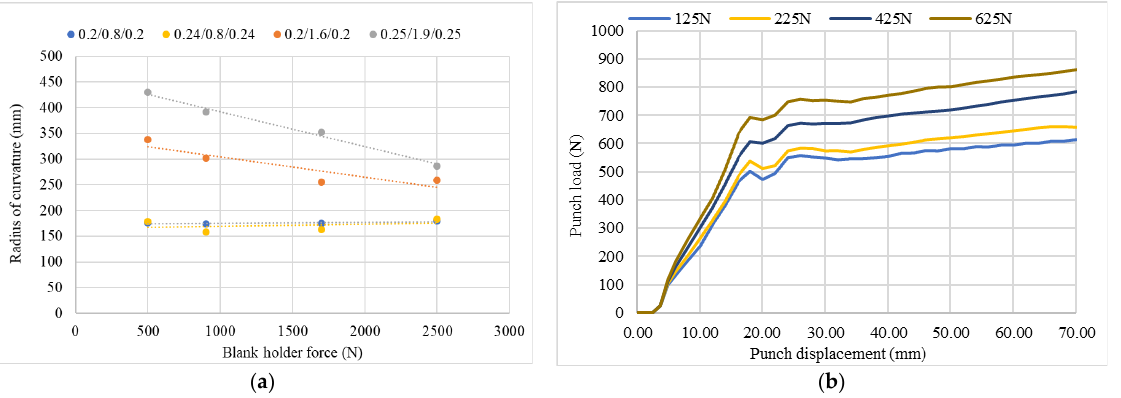
Figure 18. ( a ) Effect of BHF on radius of curvature ( b ) Load – displacement curves for varying blank holder force for the sandwich laminate with 0.24/0.8/0.24 mm thickness combination (the BHFs shown in the legend are for the quarter model).